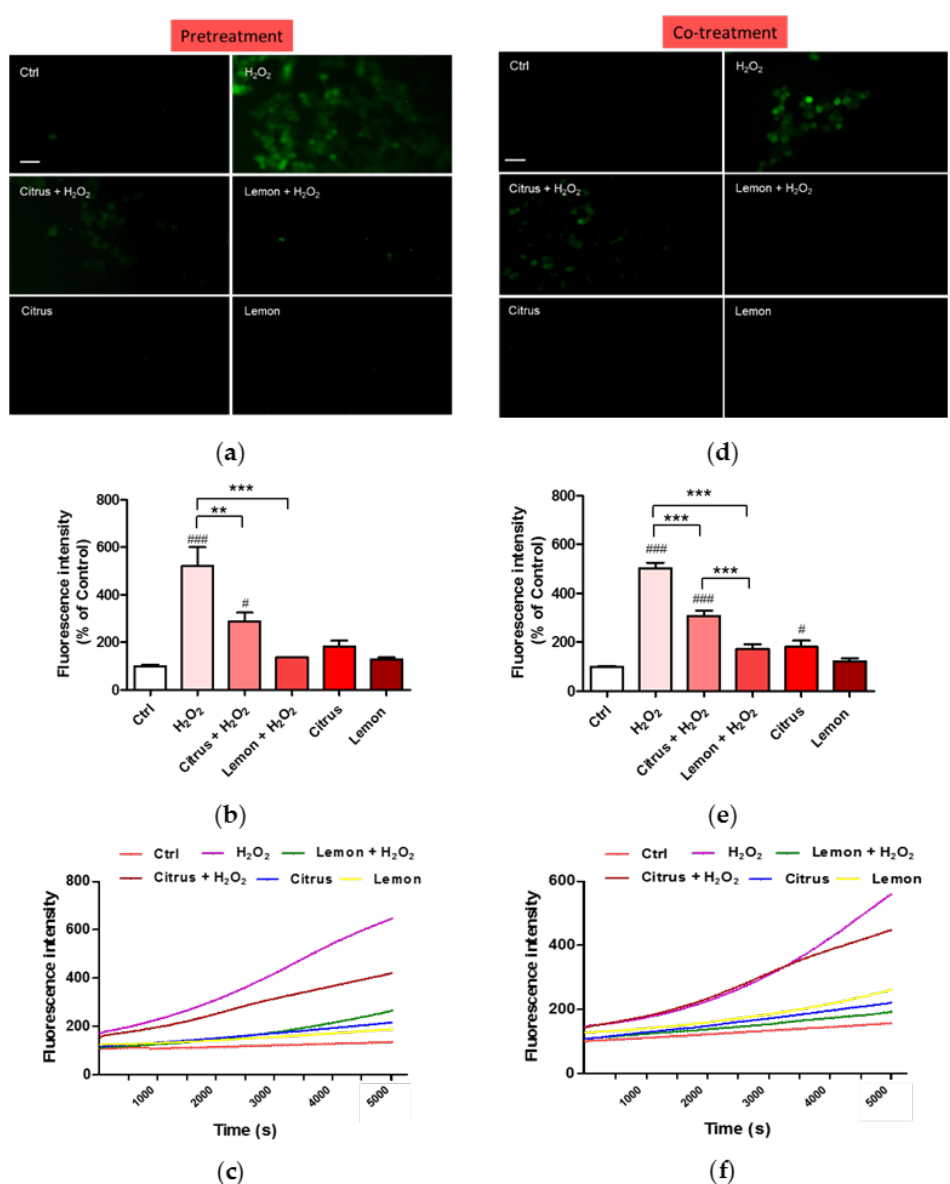
Figure 4. Effects of commercial (citrus) and lemon IntegroPectin (lemon) pectins on ROS produc- tion driven by exposure to aqueous H 2 O 2 : ( a ) fluorescence microscopy images of the pretreatment of untreated cells (Ctrl) or treated with pectins or with H 2 O 2 alone or in combination with pectins; ( b ) fluorescence intensity of the pretreatment of untreated cells (Ctrl) or treated with pectins or with H 2 O 2 alone or in combination with pectins measured by the DCFH-DA fluorescence assay; ( c ) oxidation kinetics of the pretreatment of untreated cells (Ctrl) or treated with pectins or with H 2 O 2 alone or in combination with pectins; ( d ) fluorescence microscopy images of the co-treatment of untreated cells (Ctrl) or treated with pectins or with H 2 O 2 alone or in combination with pectins; ( e ) fluorescence intensity of the co-treatment of untreated cells (Ctrl) or treated with pectins or with H 2 O 2 alone or in combination with pectins measured by the DCFH-DA fluorescence assay; ( f ) oxidation kinetics of the co-treatment of untreated cells (Ctrl) or treated with pectins or with H 2 O 2 alone or in combination with pectins. Bar: 50 μm. Tukey test: # p < 0.05, ### p < 0.001 as compared to control (Ctrl) group; ** p < 0.01, *** p < 0.001.